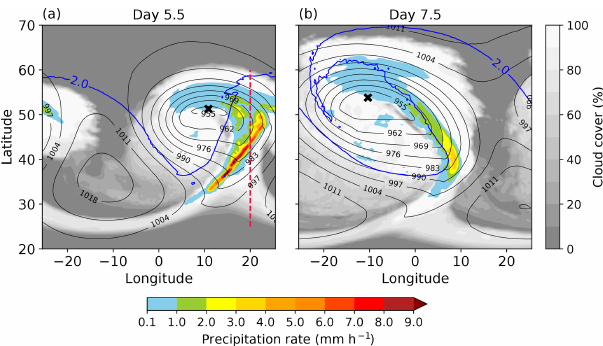
Figure 1. Surface pressure (black contours, hPa), total precipitation rate (colors) and cloud cover (gray shadings) for the cyclone sim- ulation without radiation at (a) day 5.5 and (b) day 7.5. The blue contours indicate the dynamical tropopause as given by the 2PVU contour on the 326K isentrope. The dashed red line shows the po- sition of the cross-section shown in Fig. 6. The cross shows the po- sition of the cyclone center given by the minimum surface